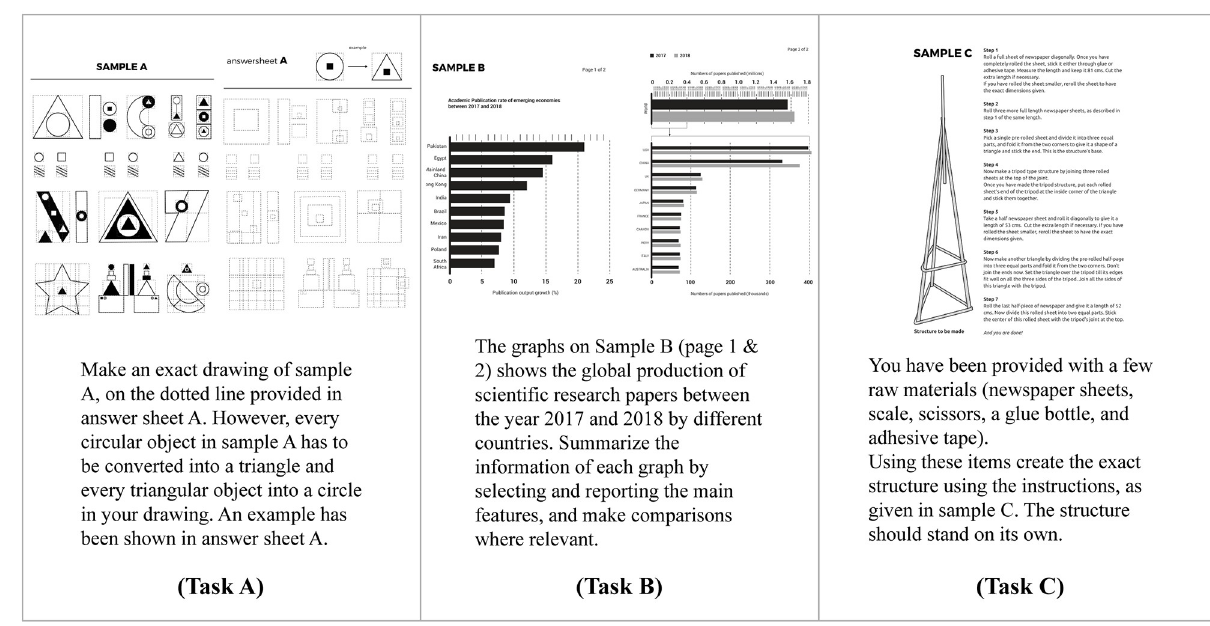
Fig 2. SPS group